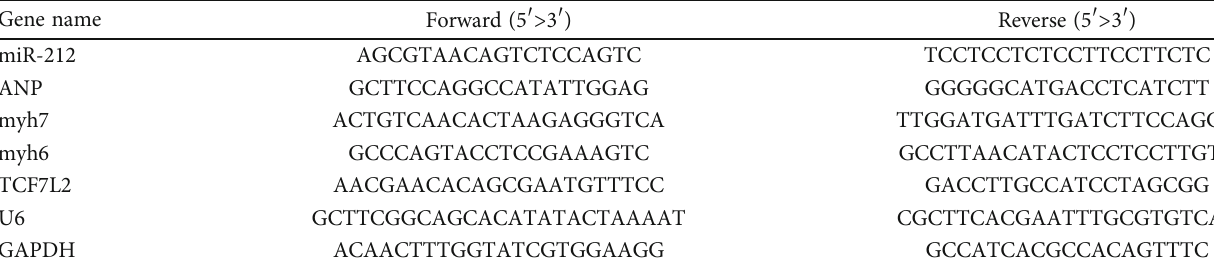
Table 1: Real-time PCR primers.